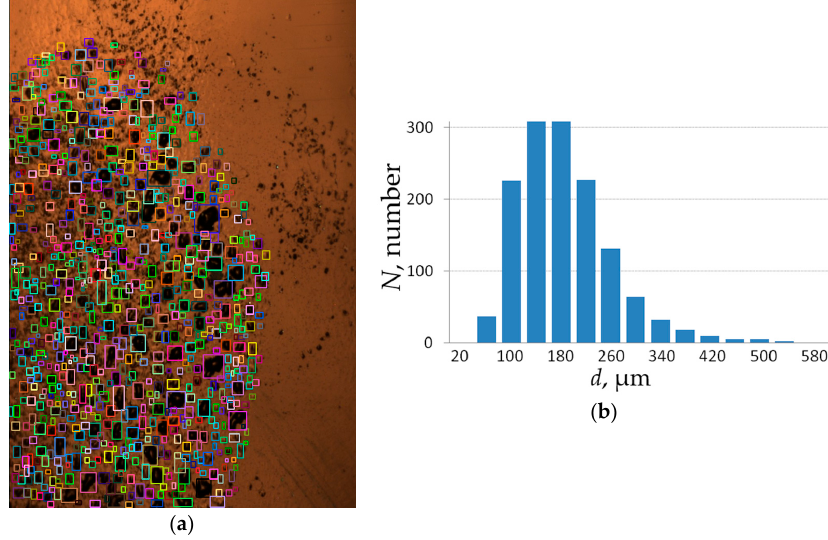
Figure 16. Result of image processing ( a ) and size distribution histogram ( b ) of blisters on the surface of 99.99996% coarse-grained copper (Sample 3). The frame size is 12 × 12 mm 2 ( a ).